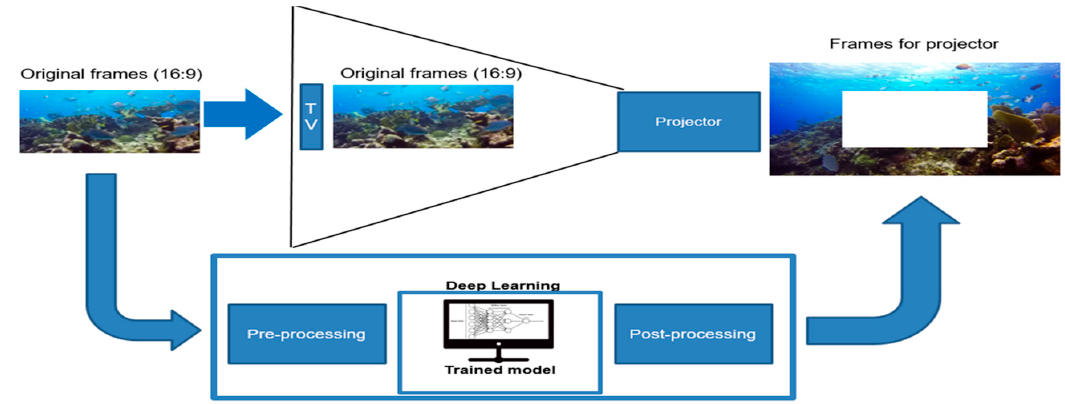
Figure 2. The general overview of the proposed approach for the generation of the context images or video frames.